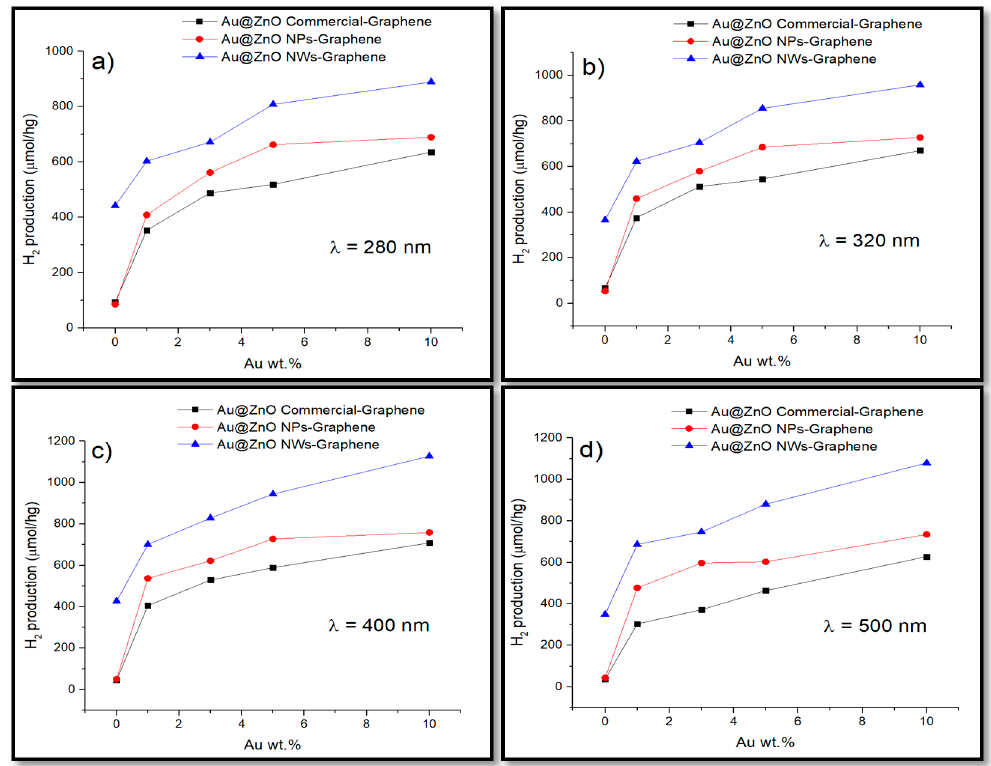
Figure 6. Photocatalytic hydrogen production of the different Au@ZnO–graphene catalysts under irradiation at 280 nm ( a ), 320 nm ( b ), 400 nm ( c ), and 500 nm ( d ).